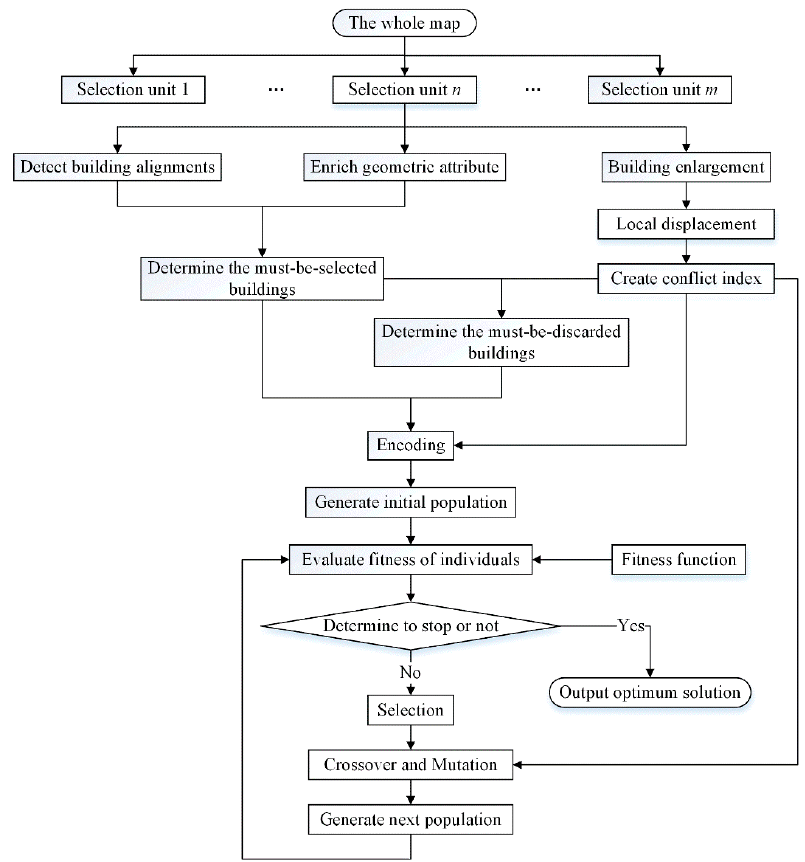
Figure 10. Buildings selection procedure.